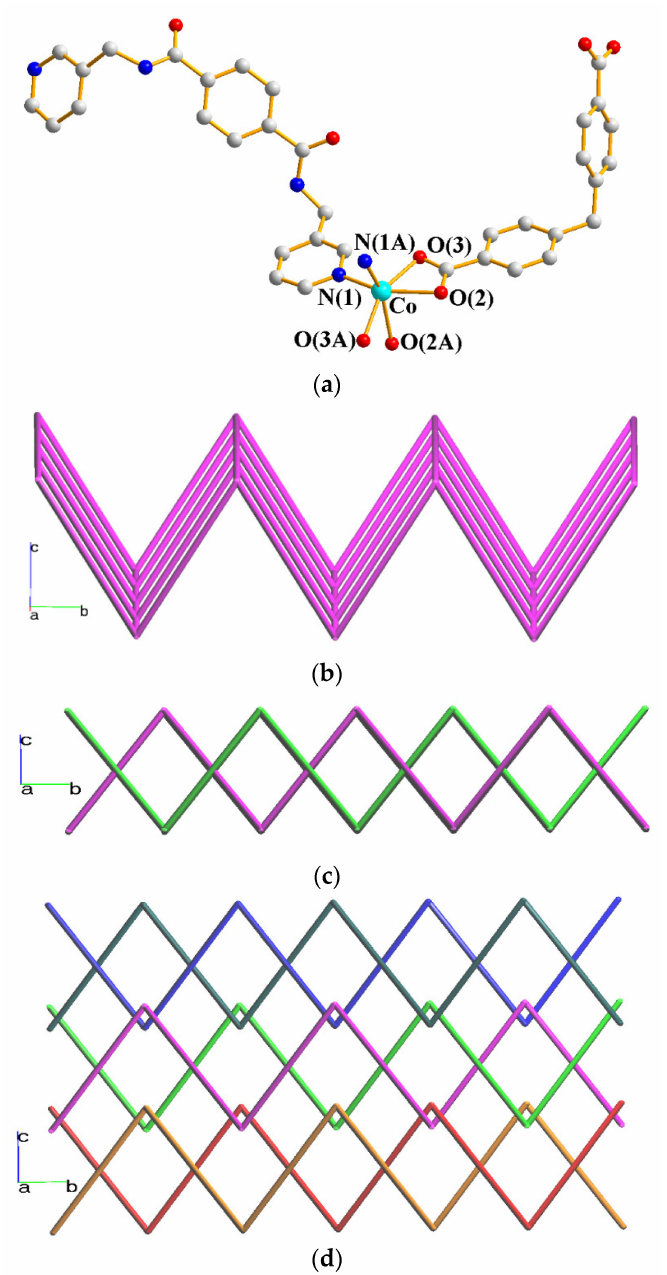
Figure 5. ( a ) Coordination environment around the Co(II) cation in 4 . Symmetry transformations used to generate equivalent atoms: (A) –x + 1, − y + 3/2, z. ( b ) A drawing showing the pleated 2D layer. ( c ) A drawing showing the 2-fold interpenetrated layers. ( d ) A drawing showing the polycatenation of 2-fold interpenetrated 2D